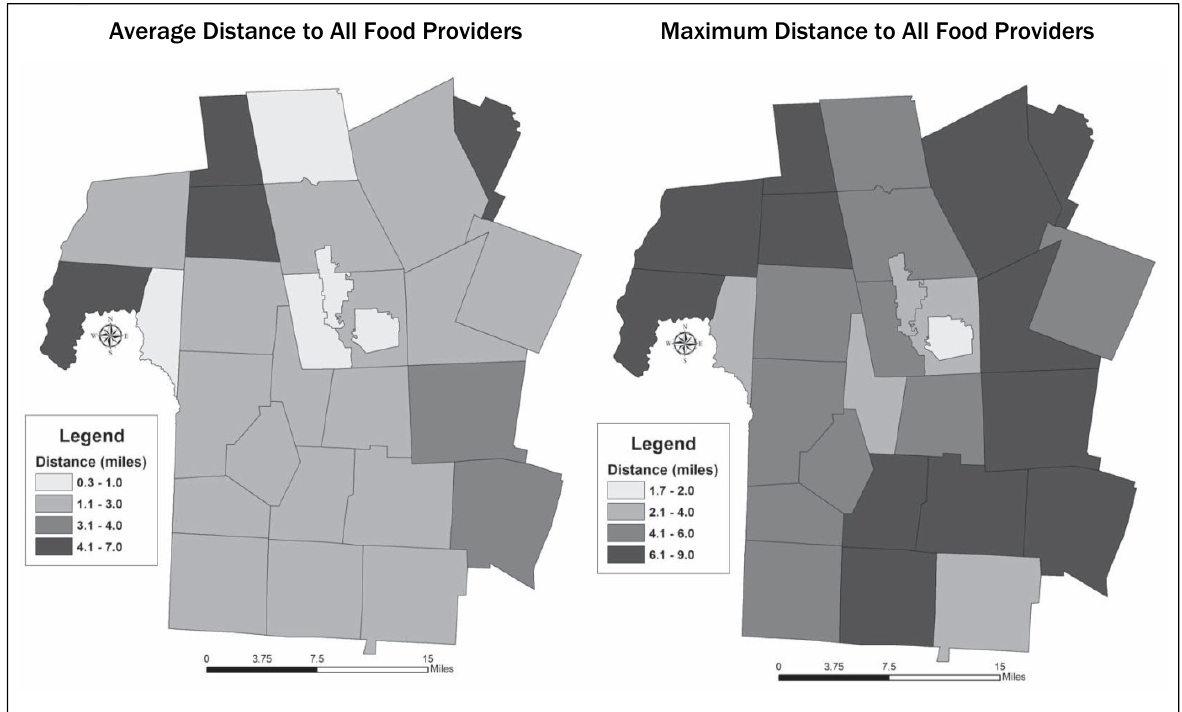
Figure 2. Maps Illustrating the Average and Maximum Distance to All Food Providers Within Rutland